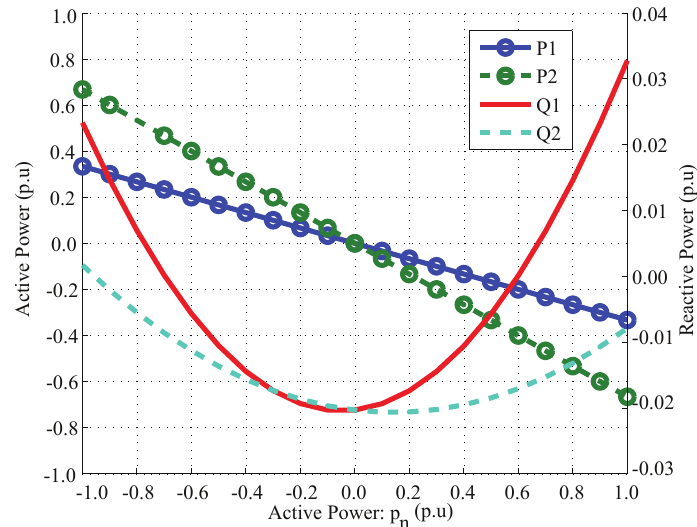
Figure 7. Power response of VSC with droop